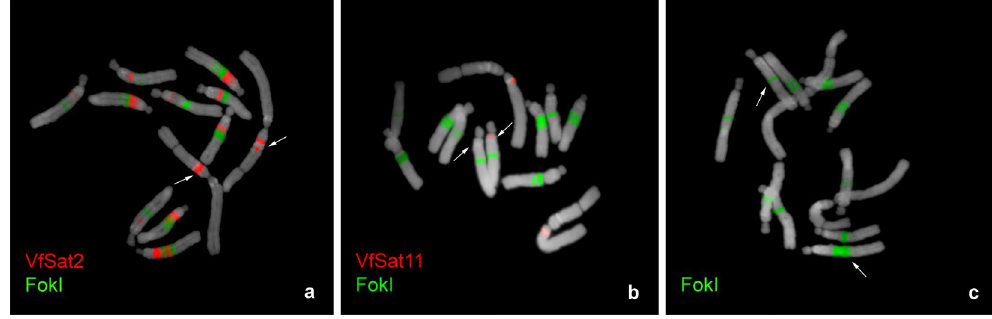
Figure 3. Variation in the number ( a , b ) or size ( c ) of FISH signals between homologous chromosomes detected for VfSat2, VfSat11, and FokI. Arrows indicate the positions of polymorphic loci on homologous